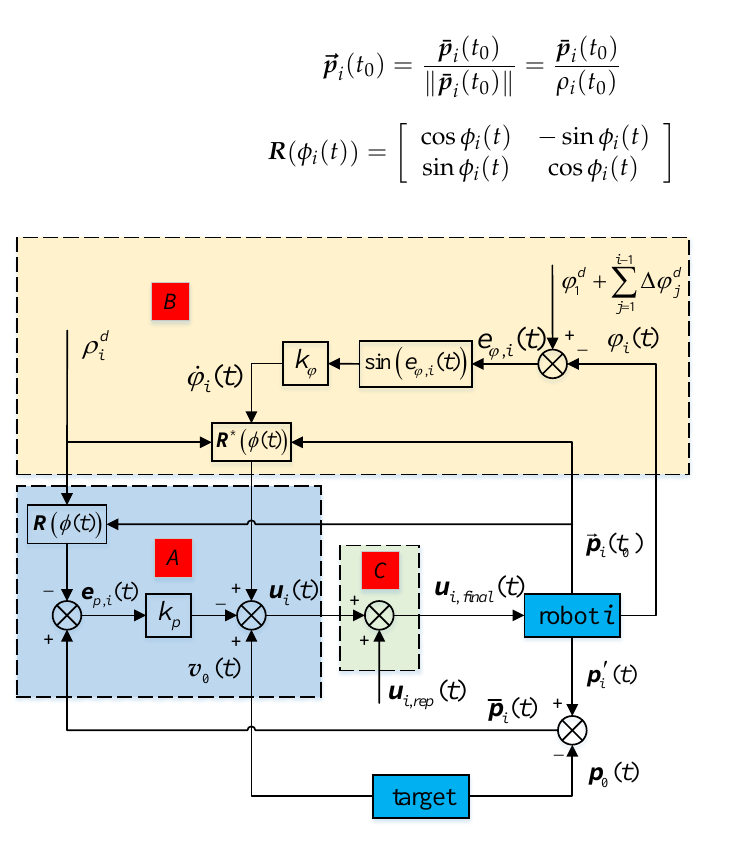
Figure 2. The structure of the designed controller